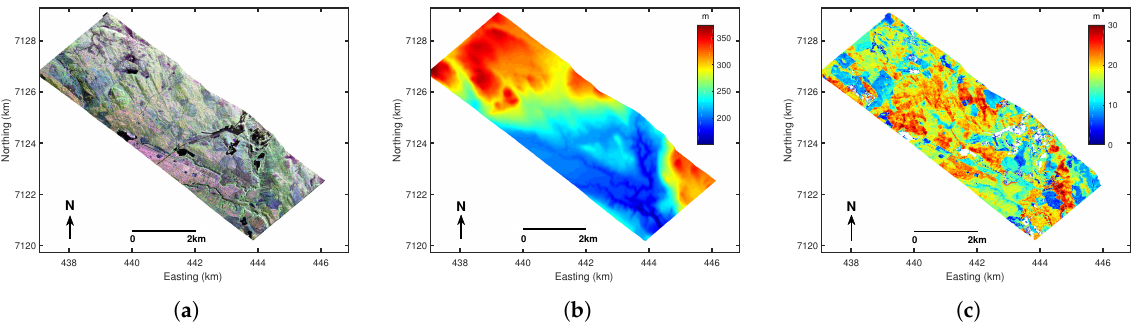
Figure 7. ( a ) The Pauli-basis polarimetric composite map, ( b ) measured DEM, and ( c ) Lidar-derived forest